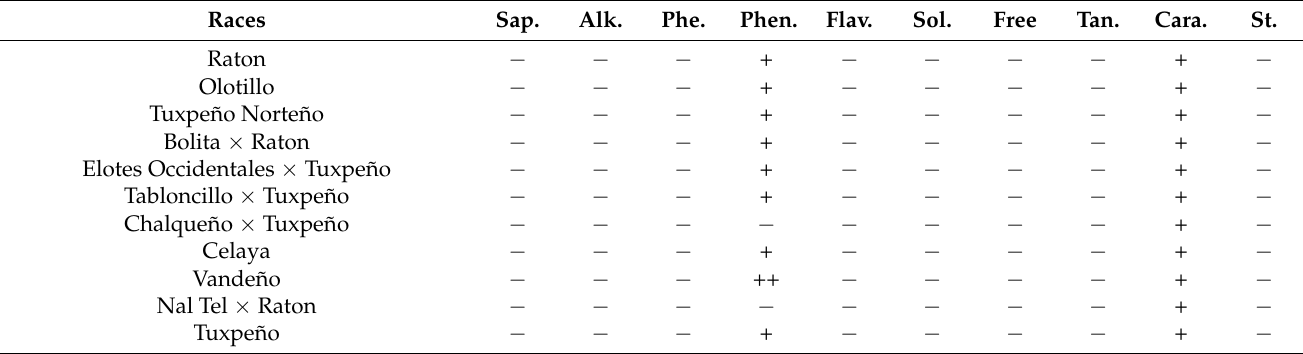
Table 1. Secondary metabolites (“+” = present; “ − ” = absent) in methanol extract of races of maize. Races Sap. Alk. Phe. Phen. Flav. Sol. Free Tan. Cara. St. Raton −